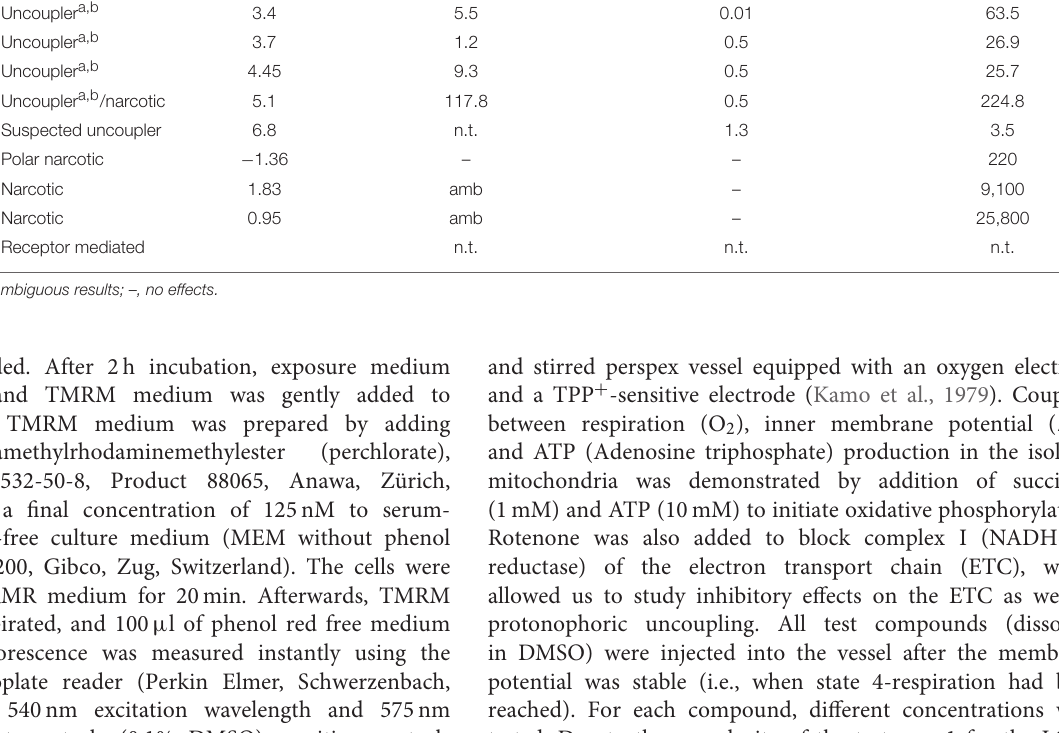
TABLE 2 | Compounds tested in the different bioassyas (TMRM, TPP + and Cytotoxicity), a biological proven uncoupler, b QSAR designated uncoupler.